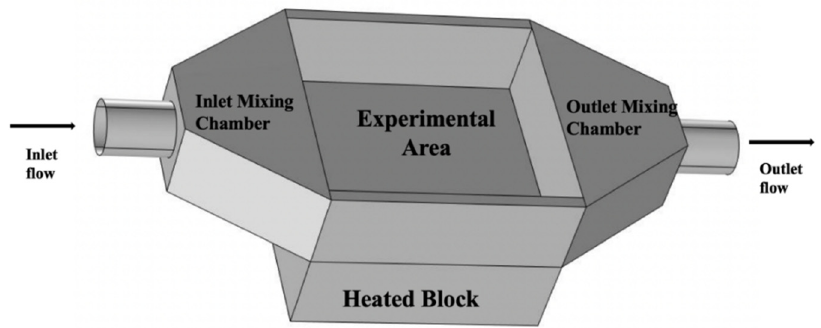
Figure 1. Experimental setup.